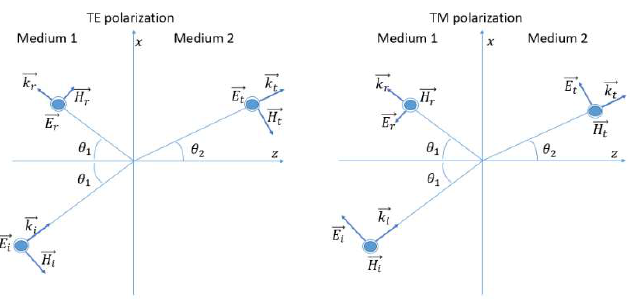
Figure 4. Reflection and transmission of a plane wave at an interface between two isotropic and homogeneous media with different electromagnetic characteristics.